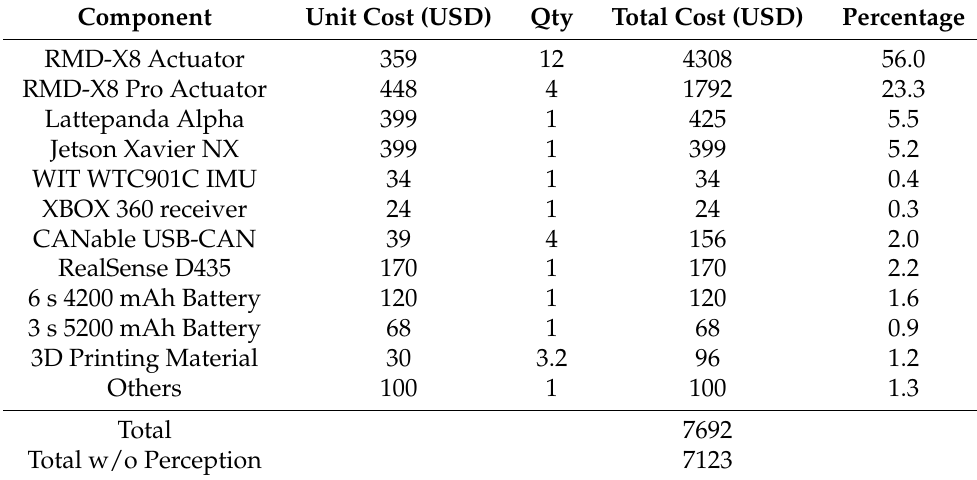
Table 5. Cost Breakdown of PADWQ.